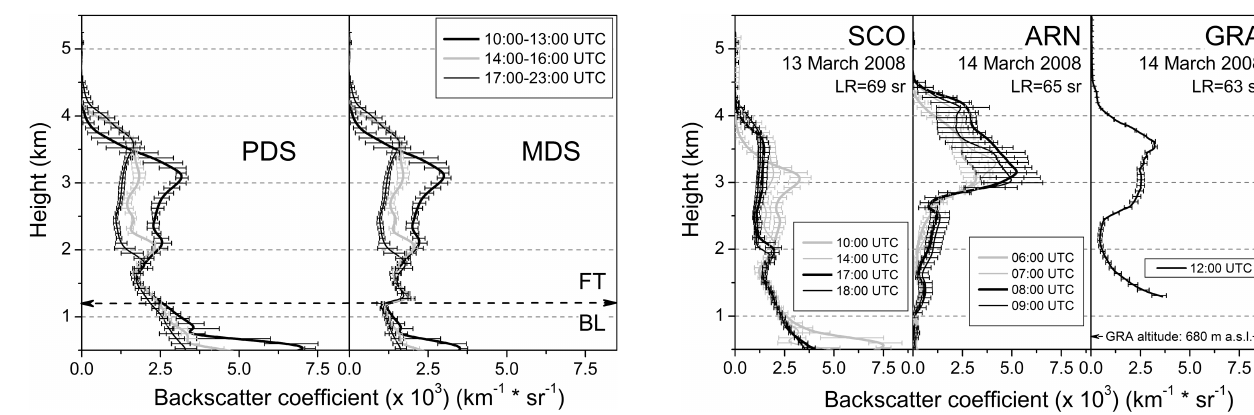
Fig. 7. Height-resolved backscatter coefficients under dusty condi- tions over SCO site (13 March 2008) for the “pure-dust scenario” (PDS) (left) and the “mixed-dust scenario” (MDS) (right) at se- lected averaged times (see legend).